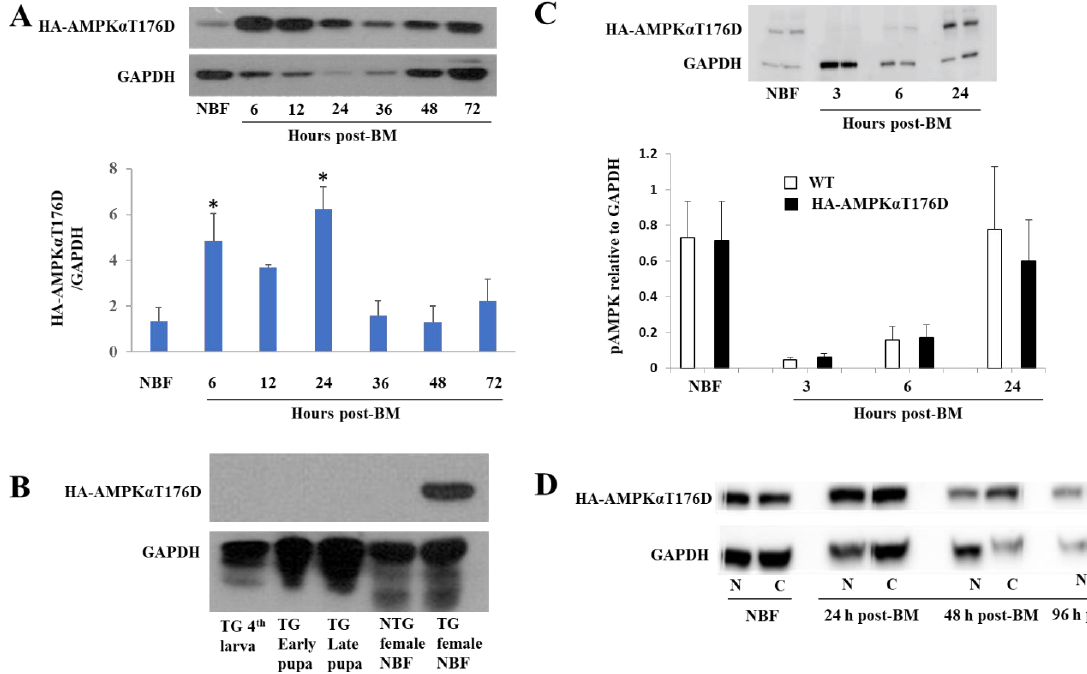
Figure 2. Expression profile of HA-AMPKαT176D. ( A ) Representative immunoblot detailing the expression of HA- AMPKαT176D and GAPDH in the midguts of non-blood-fed (NBF) and blood-fed TG mosquitoes at 6, 12, 24, 36, 48 and 72 h post-BM. The lower graph depicts the average expression of transgene protein normalized to GAPDH loading con- trols. Data are represented as means ± SEMs from three replicates with independent cohorts of mosquitoes. Significant